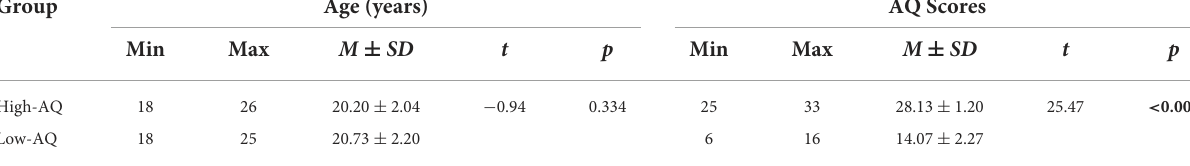
TABLE 1 Demographic characteristics of the High-AQ and Low AQ